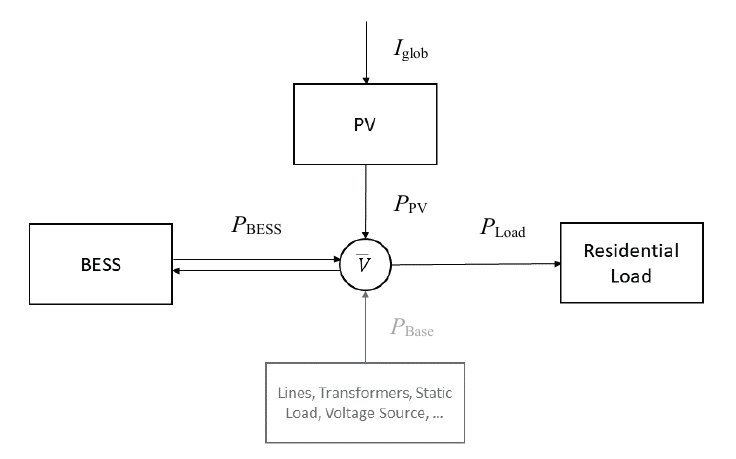
Fig. 1. Model components influencing the voltage level. Black blocks – submodels of main components, grey block – basic grid